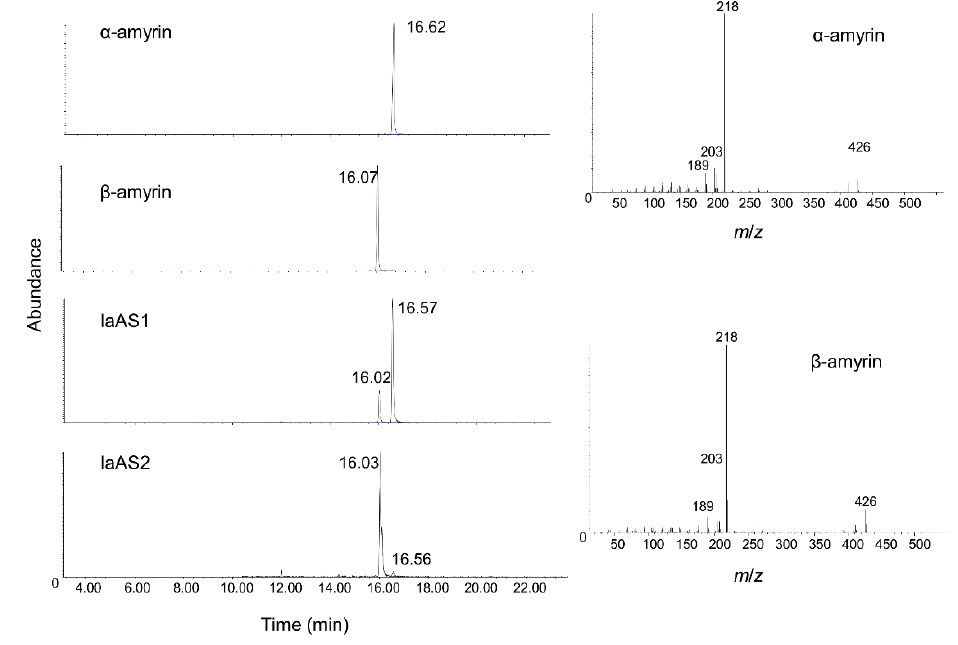
Figure 4. Gas chromatography analysis of the products of IaAS1 and IaAS2 over-expressed in yeast. pYES-DEST52 was served as a negative control and α -amyrin and β -amyrin as standards.